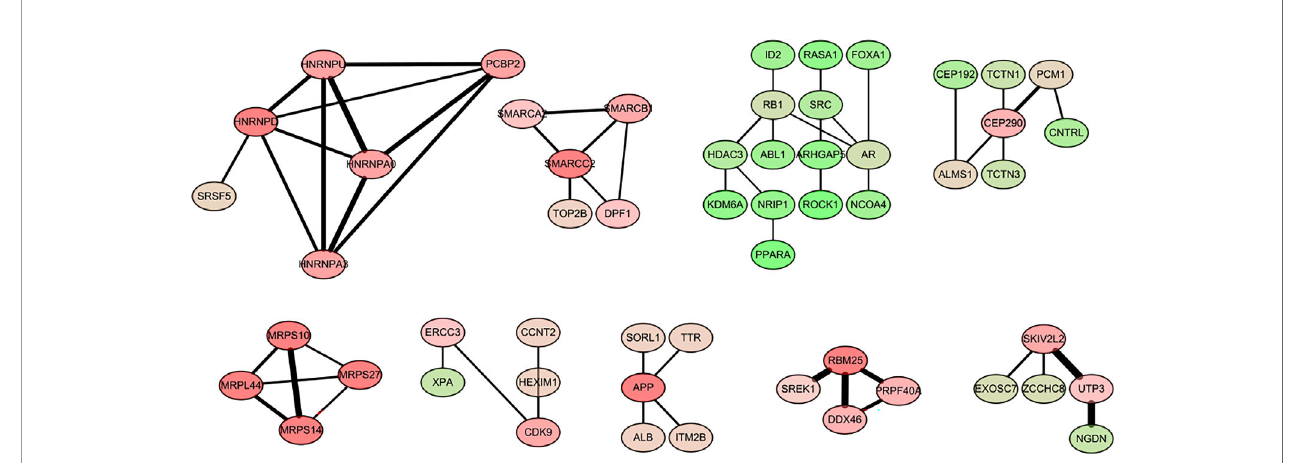
FIGURE 4 | Visualization of the protein-protein interaction (PPI) network and the candidate hub